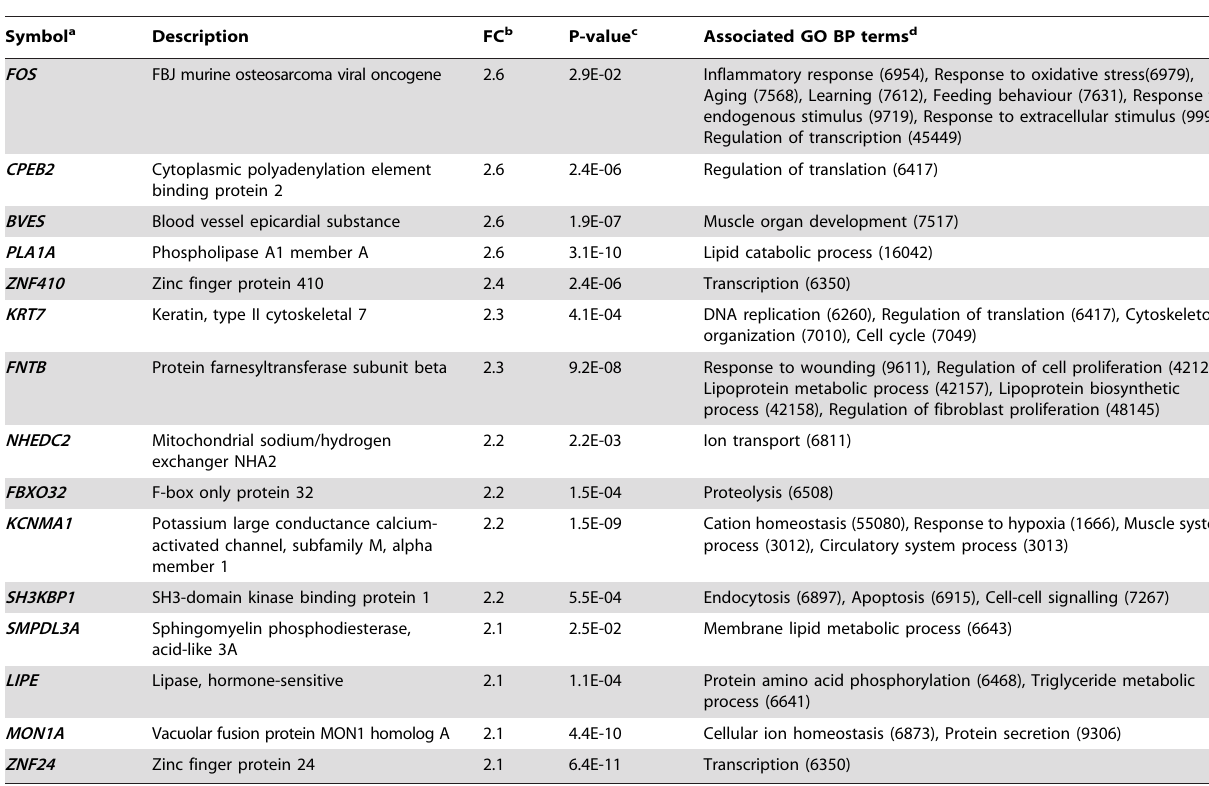
Table 2. Genes highly expressed in the Longissimus muscle of Basque pigs